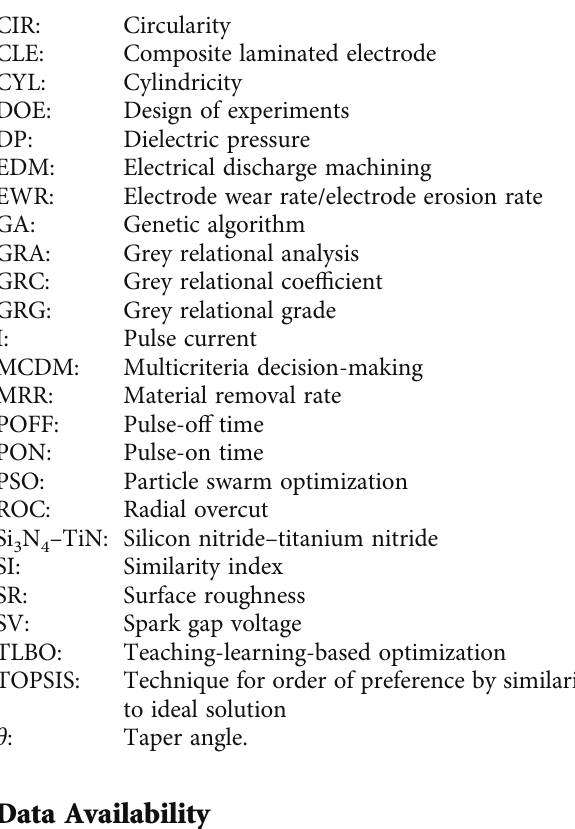
TLBO algorithm I = 12 amps, PON = 8 : 89 μ sec, POFF = 7 : 09 μ sec, DP = 14 : 04 kg/cm 2 , and SV = 28